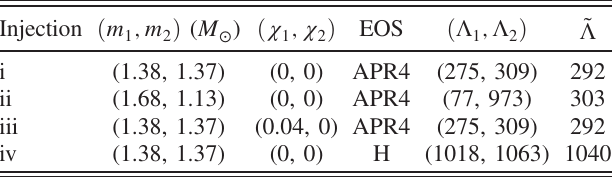
TABLE VI. Parameters used for the injected SEOBNRv4T waveform. The chosen masses and spins are consistent with the measured posteriors for GW170817. The tidal parameters are calculated from the mass and chosen EOS.